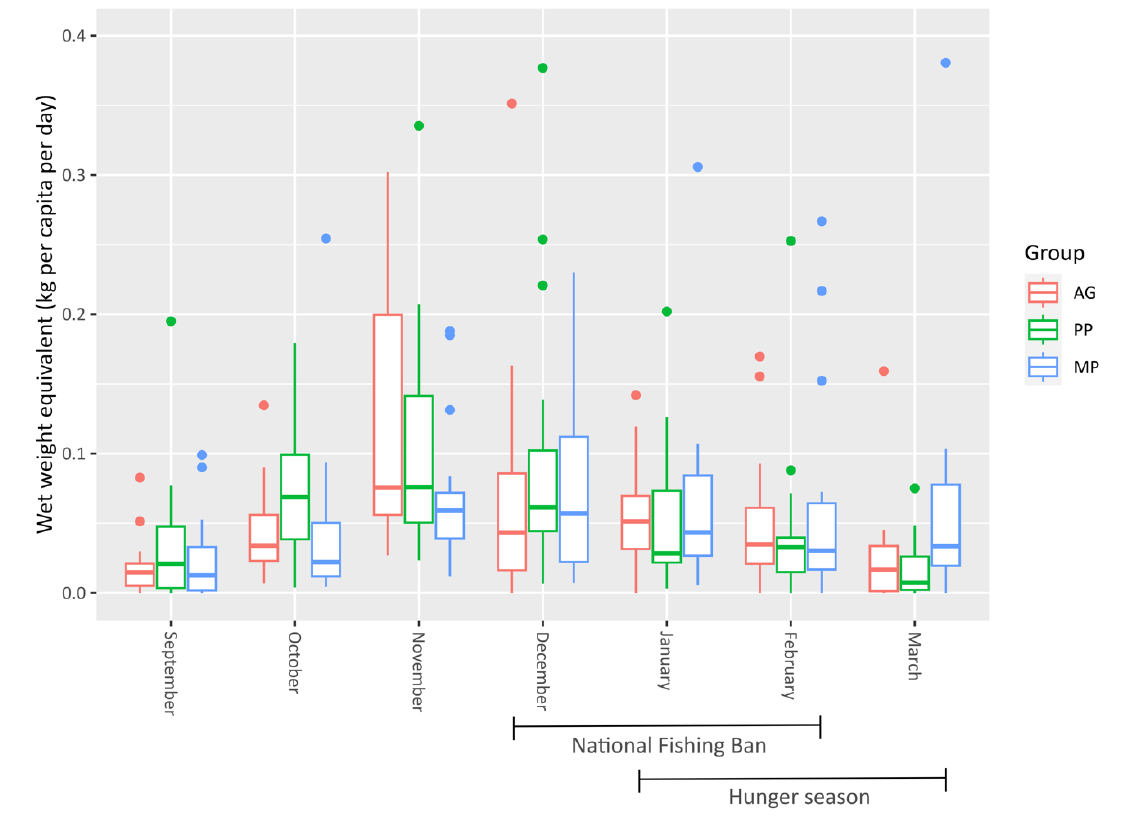
Figure 2. The monthly quantity of fish consumed, with the wet weight equivalent in kilograms per capita per day, for the three treatment groups. Outliers above 0.4 kg have been truncated for clarity, removing 4 observations.